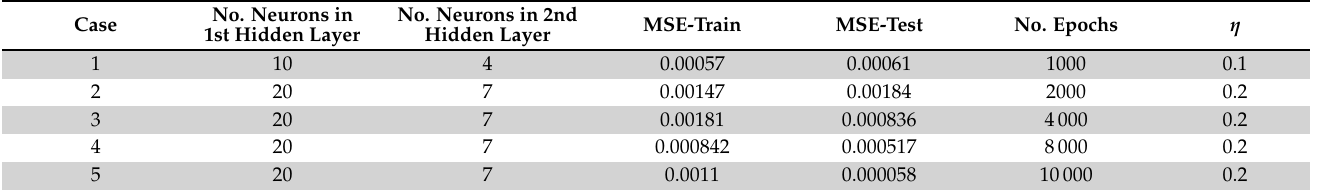
Table 3. The features of the MFNNs algorithm including the MSE of training and test